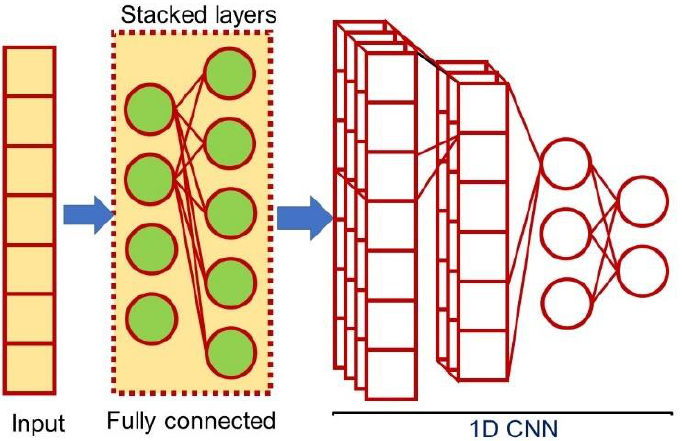
Figure 6. Schematic of a one-dimensional fully connected layer first convolutional neural network.